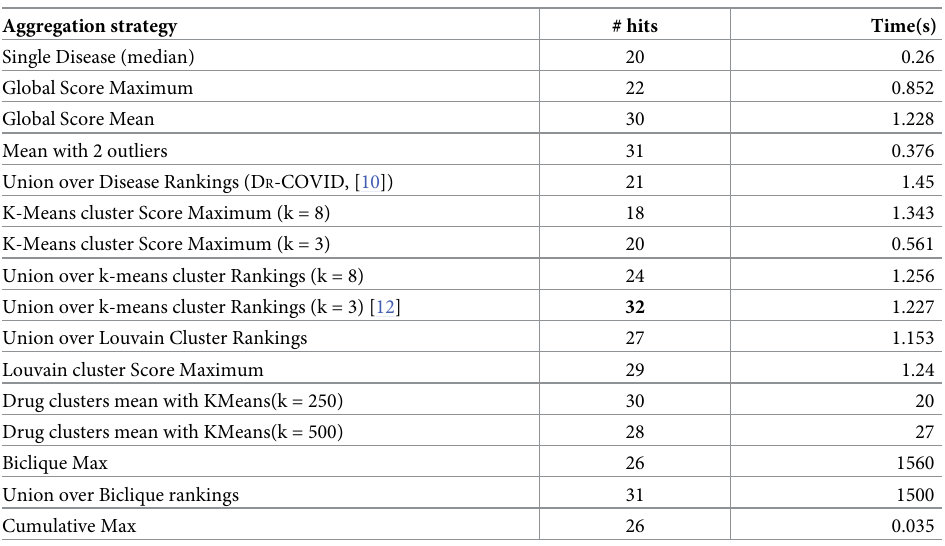
Table 1. Hits of proposed candidates in actual clinical